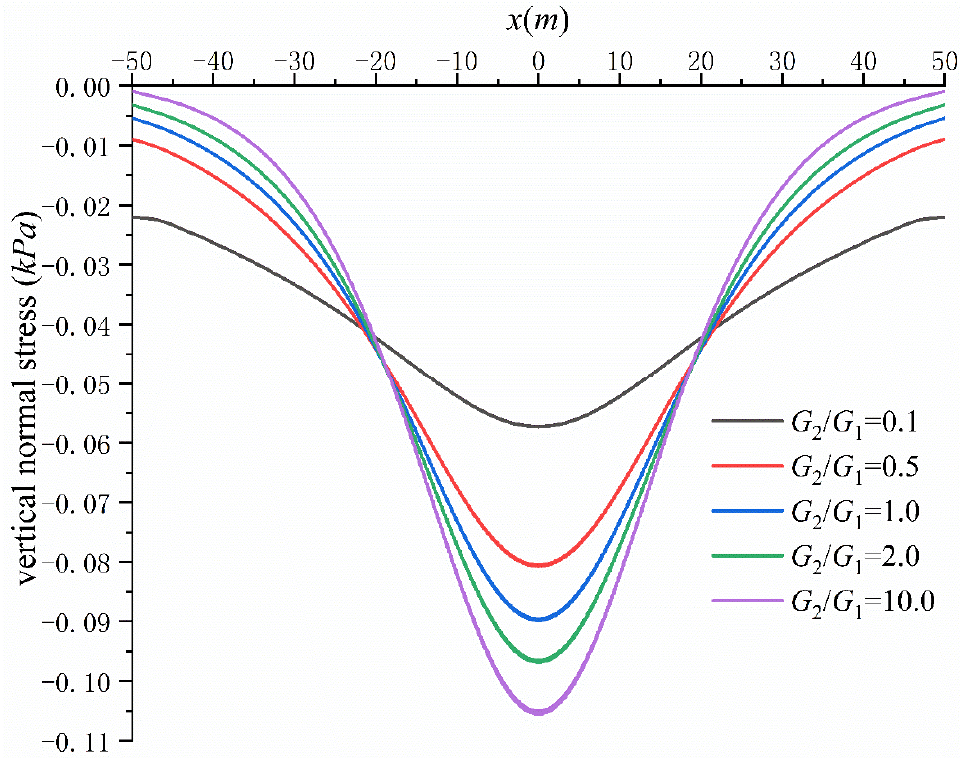
Figure 13. Effect of layered soil on vertical normal stress at interface.